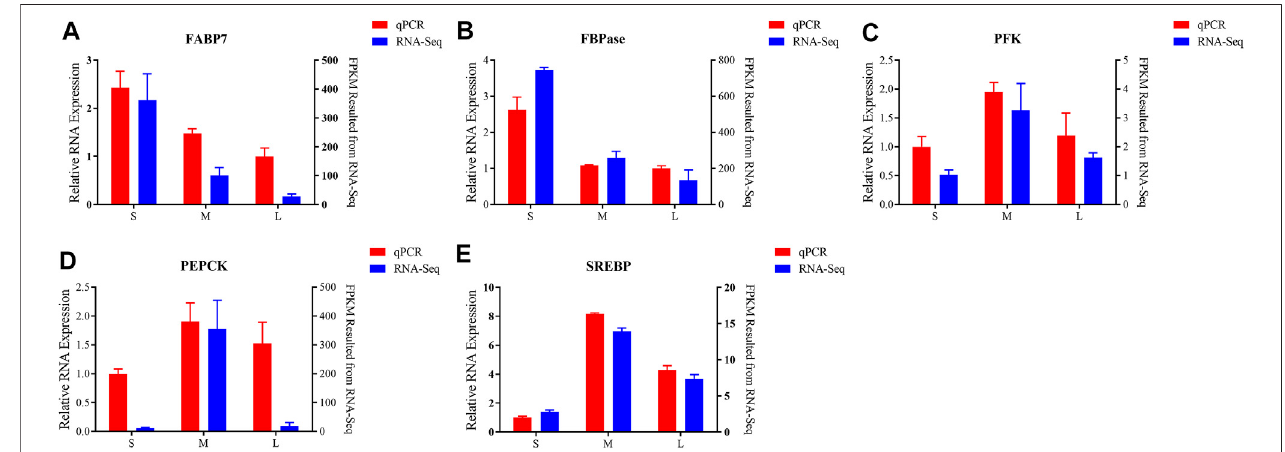
FIGURE6| Validationofsixdifferentiallyexpressed ofFABP7 (A) ,FBPase (B) ,PFK (C) ,PEPCK (D) ,SREBP (E) byqPCR.Left y axisshowstherelativeexpression levels of genes using qPCR, and the right y axis shows the fragments per kb per million reads (FPKM) values of the using RNA-seq. Data are shown as means ± SEM. Three biological replicates were